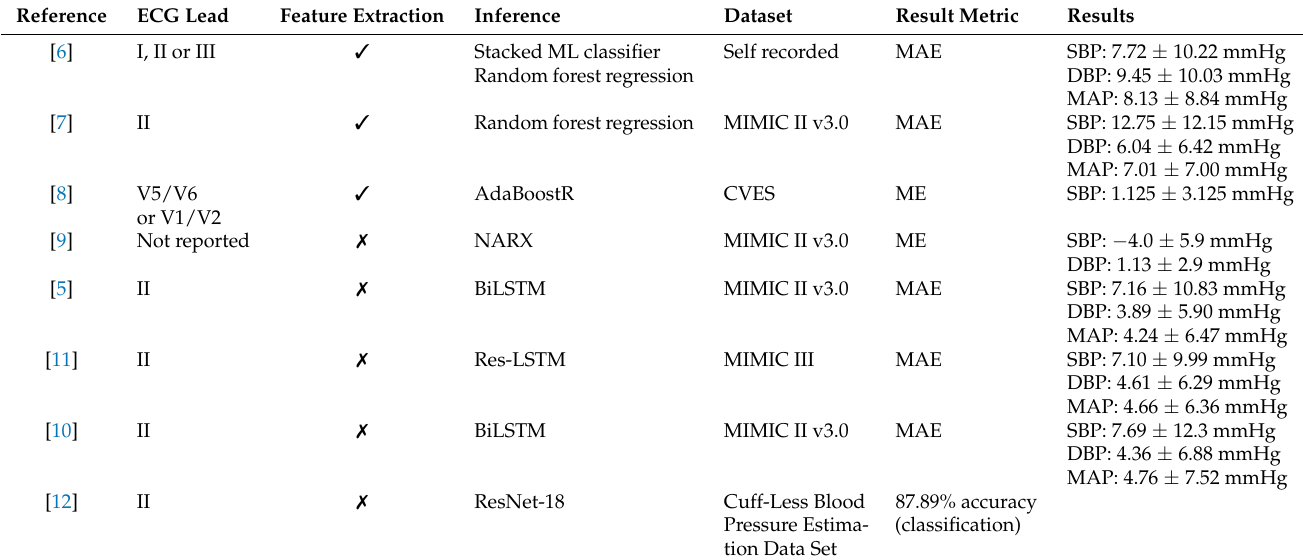
Table 1. Survey of algorithms for cuff-less blood pressure estimation through ECG